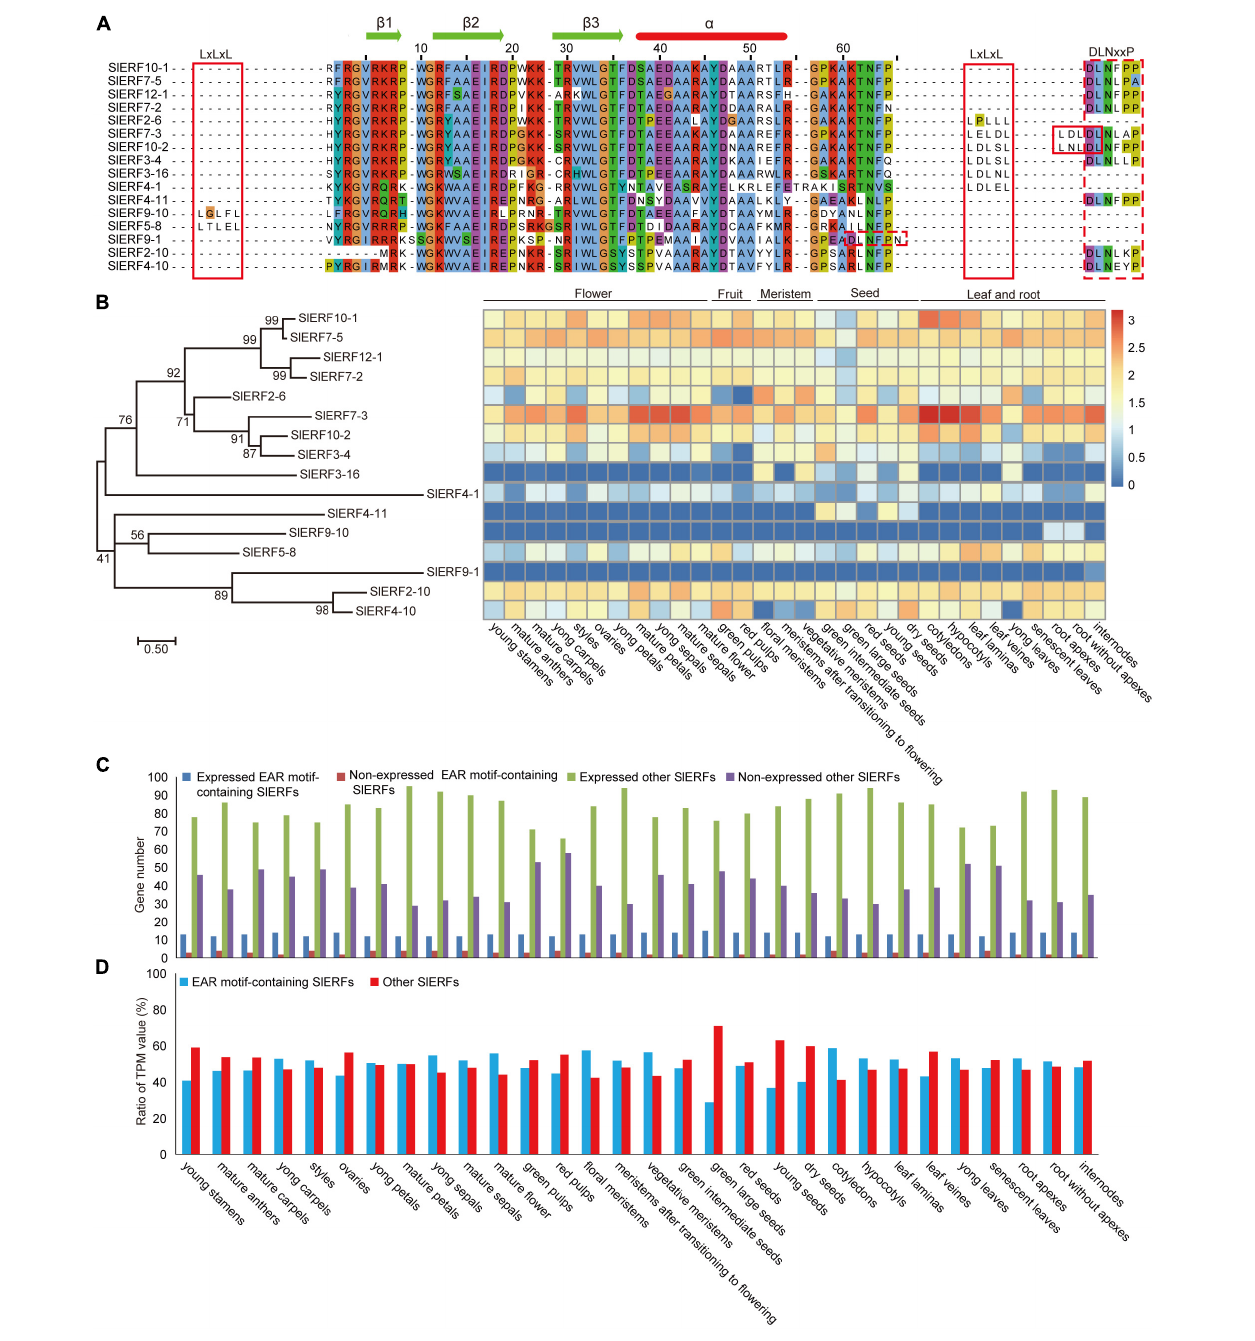
FIGURE 5 | Expression levels of the EAR motif-containing SlERF genes in 30 tomato organs. (A) AP2 domain and EAR motifs analysis in the EAR motif-containing SlERF proteins. (B) Heatmap analysis of all EAR motif-containing SlERF genes based on TPM values in 30 tomato organs. (C) Gene numbers analysis of the expressed and non-expressed genes among EAR motif-containing SlERFs and other SlERF genes in 30 tomato organs. (D) The total TPM ratio analysis of the EAR motif-containing SlERFs and other SlERF genes in 30 tomato organs.